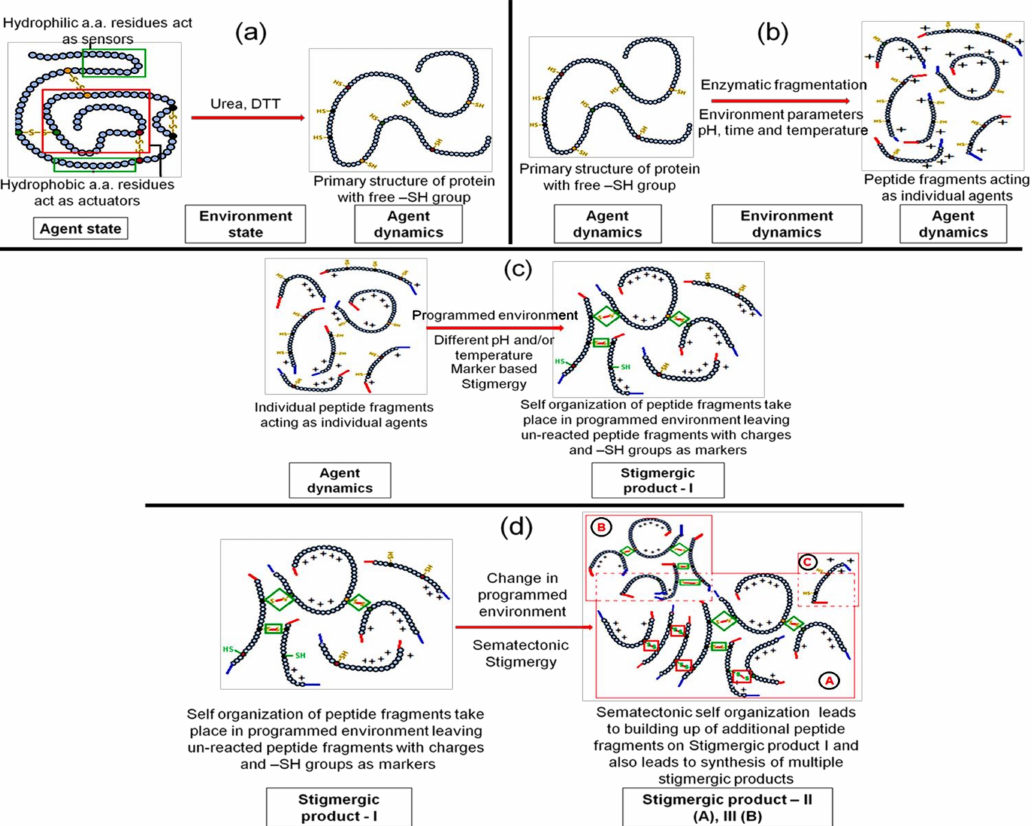
Figure 2. Stigmergy-based mechanism of protein digestion and new peptide biomaterial synthesis. ( a ) Engineering agent-state to agent-dynamic; ( b ) Engineering the environment’s dynamic and multi-agent systems; ( c ) Marker-based stimulus to generate stigmergic product; ( d ) Sematectonic emergence of stigmergic